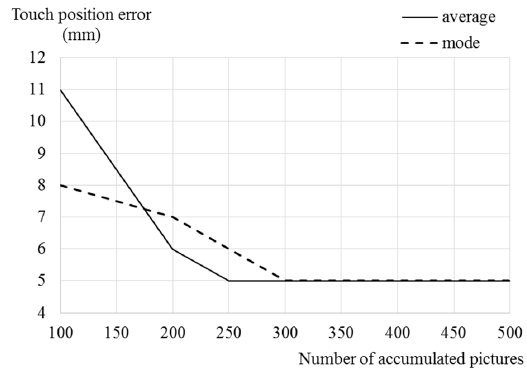
Figure 14. Touch position error according to obtaining methods of depth values of virtual touch panel and the number of accumulated pictures.